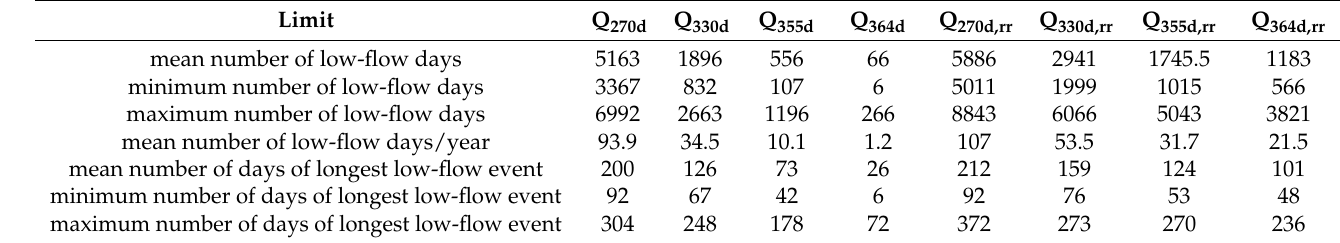
Table 2. The number of days with Q d < limit (1961–2015); statistics from all